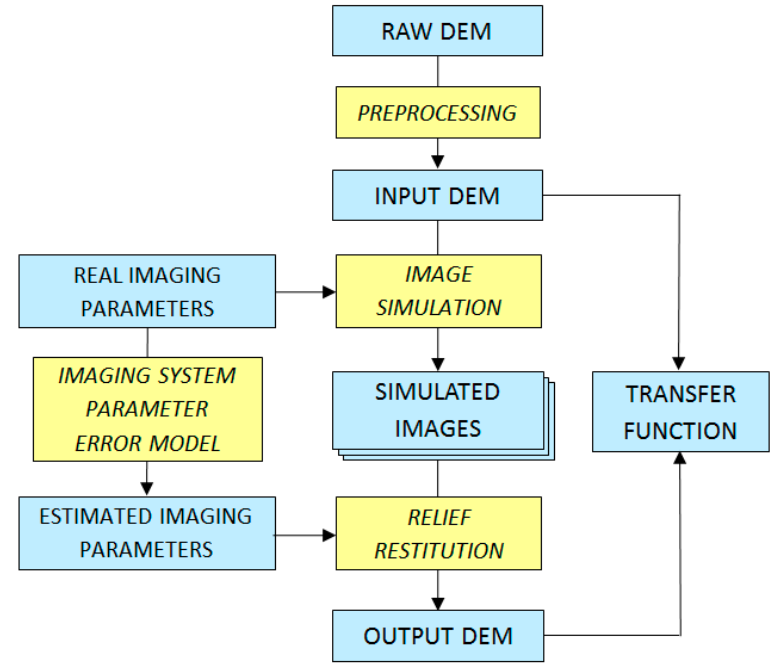
Figure 6. General workflow of simulation-based evaluation of topographic restitution methods.